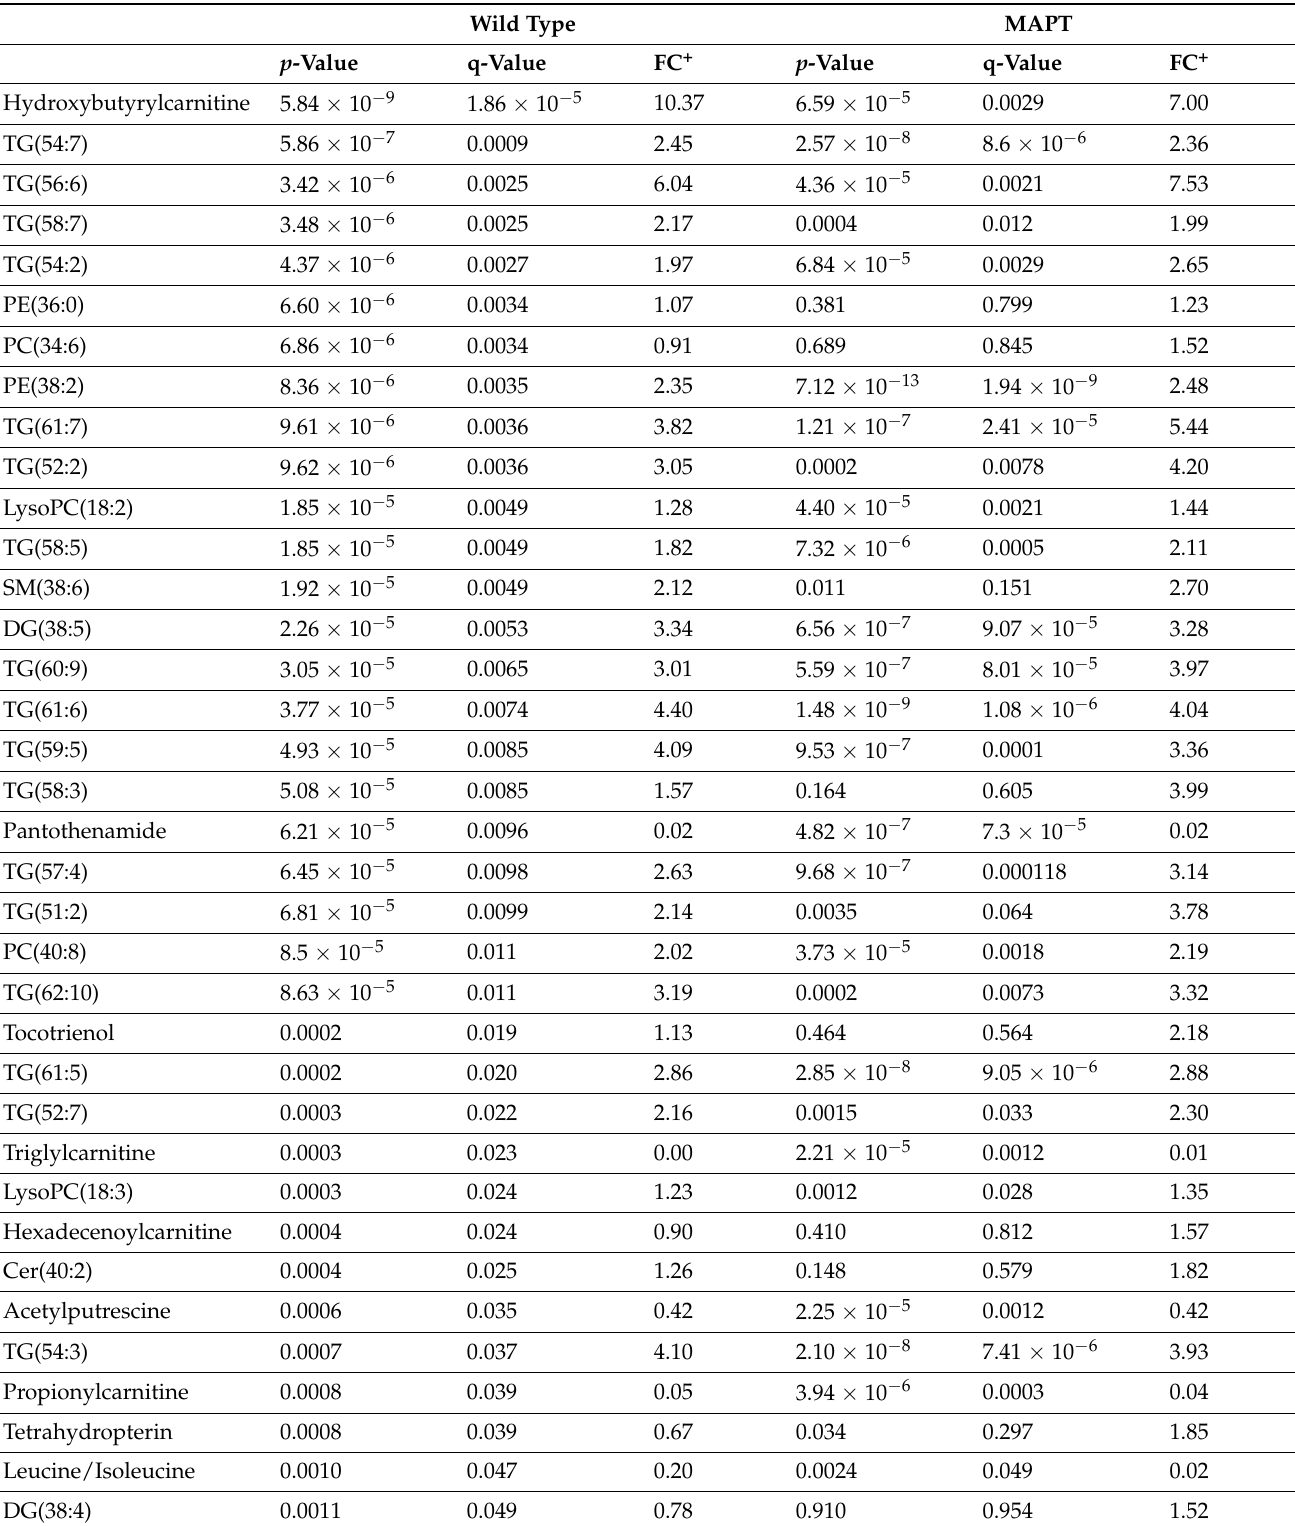
Table 1. Annotated metabolites associated with rotenone treatment in both wild type and MAPT mutant dopamine